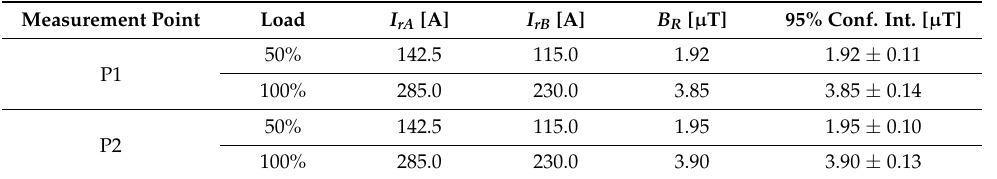
Table 4. Evaluation of magnetic field exposure for points P1 and P2.